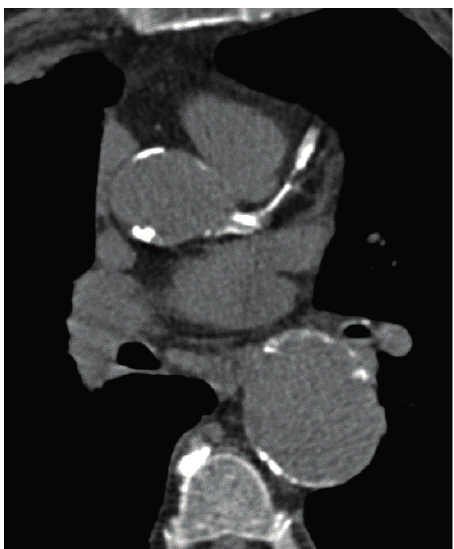
Figure 1. Native calcium scan with severe calcification of left main, left anterior descending (LAD) and the